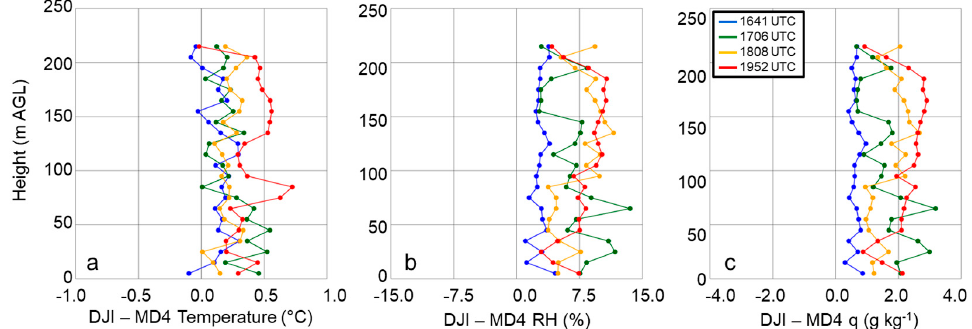
Figure 7. Comparison between measurements of temperature ( a ), relative humidity ( b ), and specific humidity ( c ) from the iMet-XQ sensors on the DJI S-1000, and those on the MD4-1000 sUAS. Both aircraft were flown simultaneously ≈ 50 m apart at Cullman 28 April 2017. Blue, green, orange, and red lines coincide with flights made 1641-1650 UTC, 1706-1714 UTC, 1808-1820 UTC, and 1952-2007 UTC, respectively. Data were averaged into 10-m bins.